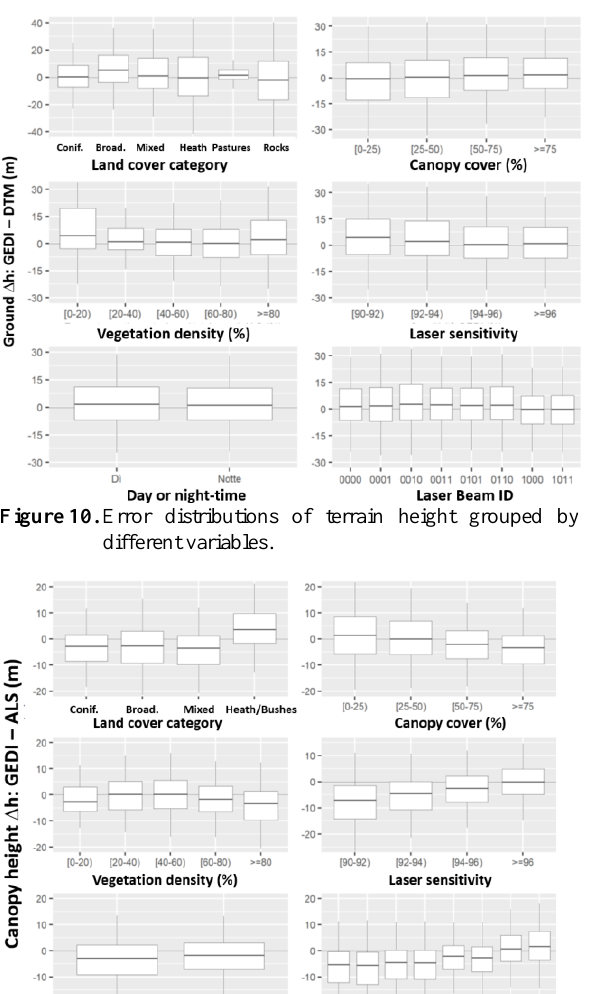
as canopy height differences follow the same